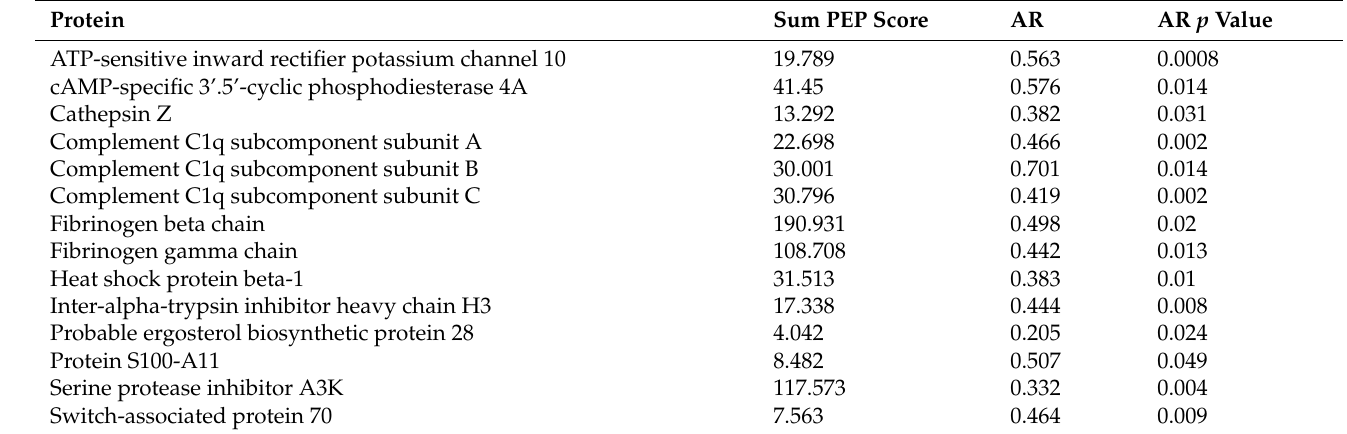
Table 2. Key proteins associated with the underexpressed pathways in hyh mice 14 days after BM- MSC treatment at P4. Sum PEP score corresponds to the score calculated based on the posterior error probability (PEP) values of the peptide spectrum matches (PSM). Sum PEP score indicates the probability that an observed PSM is incorrect. Abundance ratio (AR) indicates the relation of the protein expression in BM-MSC-transplanted mice/sham-injected hyh